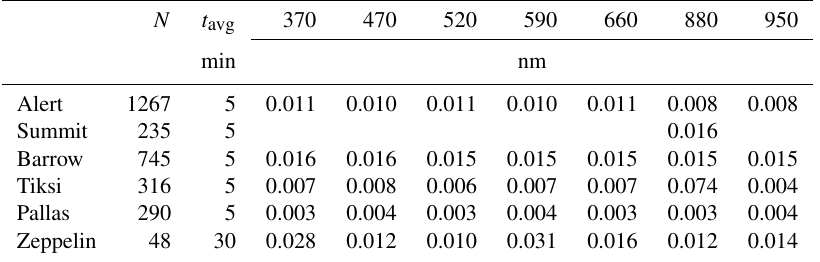
Table 2. Standard deviations of δ(cid:49) ATN ND for the different Aethalometers and their measurement wavelengths. The filtered air noise mea- surements consist of at least 24h of data, except for Alert where data was comprised of a few hours of measurements totalling 4 days. The standard deviation was calculated from subsequent reported ATN values as such and can therefore be used to reproduce Fig. 4. The t avg column shows the instrument setting for the outer cycle of the instrument during the time of the noise measurements. N t avg 370 470 520 660